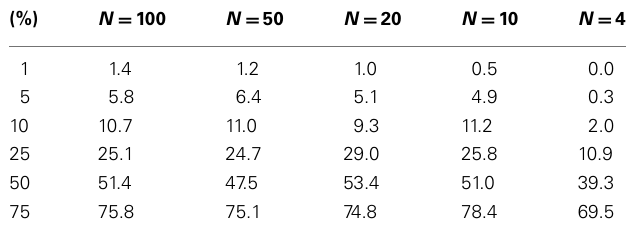
Table 1 | Level accuracy of a permutation test as a function of decreasing sample size over 1000 simulations for a single dichotomous (categorical) predictor